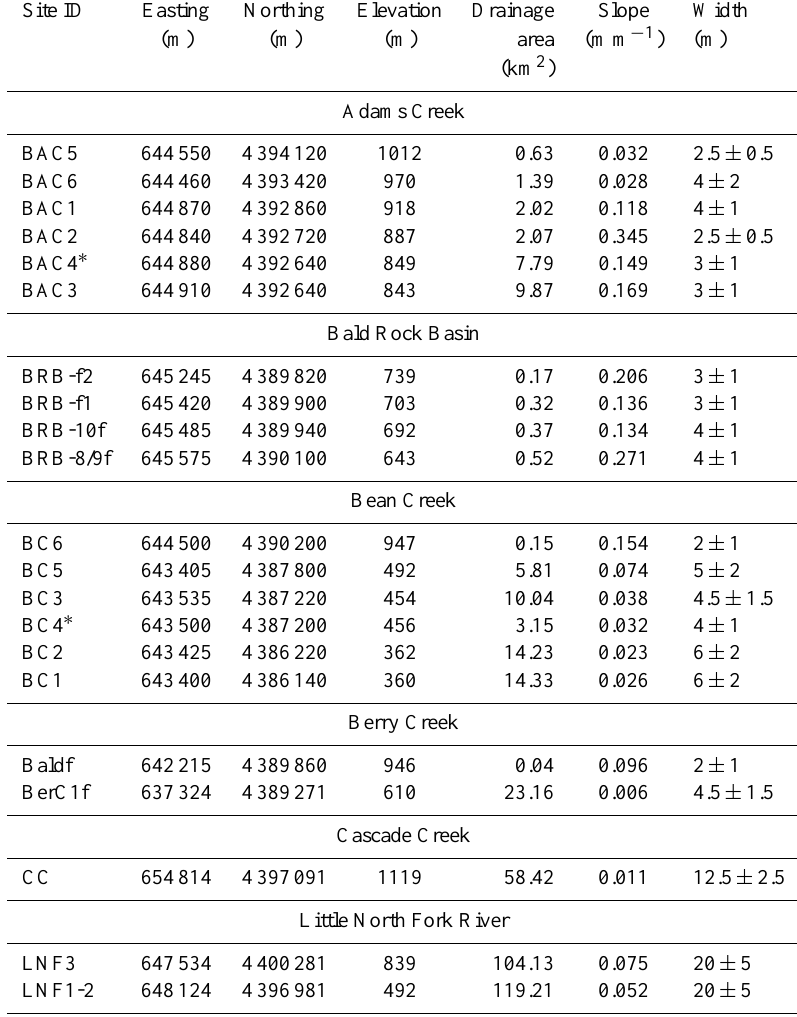
Table A3. Location and description of fluvial sites. Coordinates are in the UTM reference system (WGS1984). For each river, sites are ordered downstream (asterisk indicates sites on tributaries). Drainage area and channel slope (calculated over 100m) were extracted from the 1m resolution lidar-derived DEM, except for the Cascade Creek and lowermost Berry Creek sites, where the 10m resolution USGS DEM data were used instead. Minimum and maximum channel widths were measured over a 100m long stretch on lidar-derived DEM complemented with Google Maps images; mean width is given, with ± representing the difference between mean and